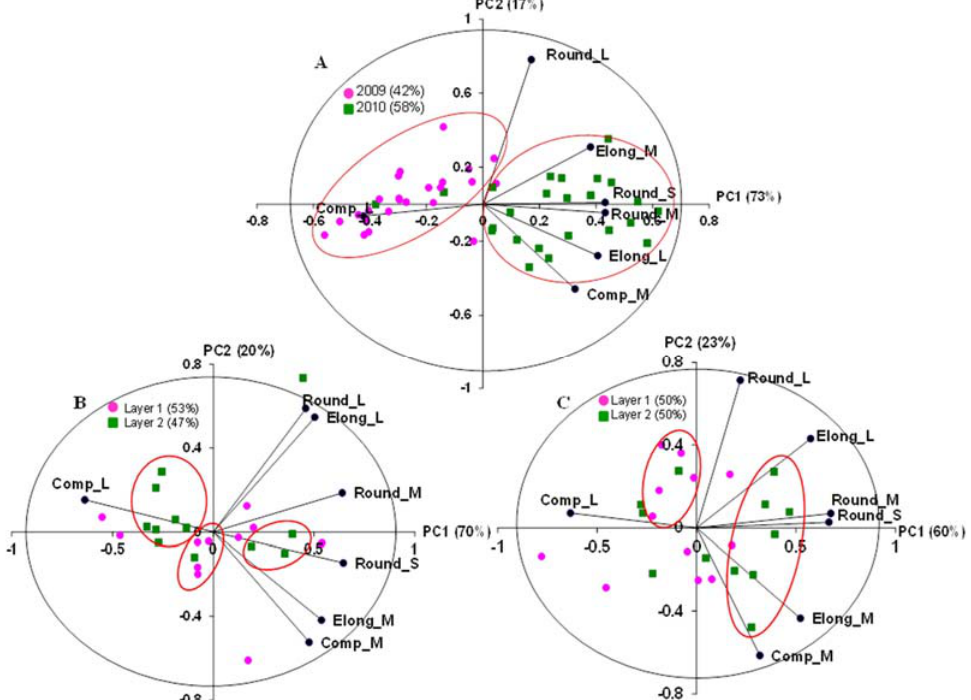
Figure 3. ( A ) PCA of the percentage of pore area in both years of study (2009 and 2010); ( B ) PCA of the percentage of pore area in the layers for 2009 and ( C ) PCA of the percentage of pore area in the layers for 2010 for a Haplic Acrisol, municipality of Piracicaba, São Paulo State, Brazil. Pore shapes (Round: rounded; Elong: elongated; Comp: complex) and sizes (S: 156–15,600 µ m 2 ; M: 15,600–156,000 µ m 2 and L: >156,000 µ m 2 ). PC1: Principal Component 1; PC2: Principal Component 2.